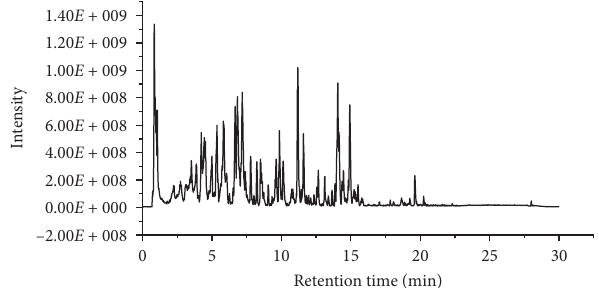
Figure 2: Total ion chromatogram of A. argyi in negative ion